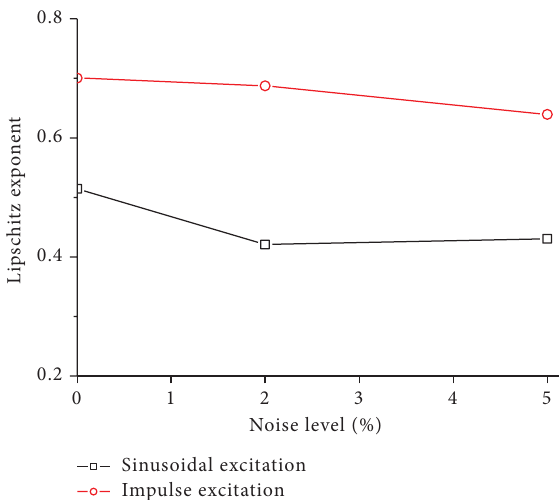
Figure 16: Variations of Lipschitz exponent with noise intensity under sinusoidal and impulse